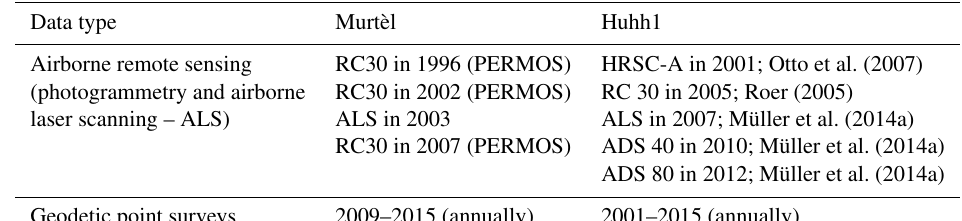
Table 2. Airborne and terrestrial remote sensing data available at the rock glacier sites.